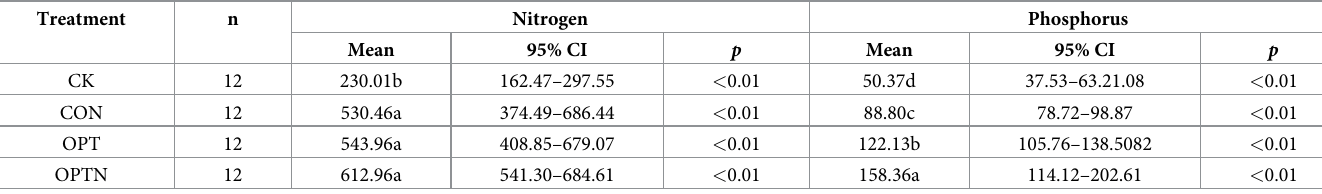
Regression results are corresponding to those in Fig 3. n, number of samples; CI, confidence interval. Growth difference of cotton under different treatments is significant when P < 0.05, vice